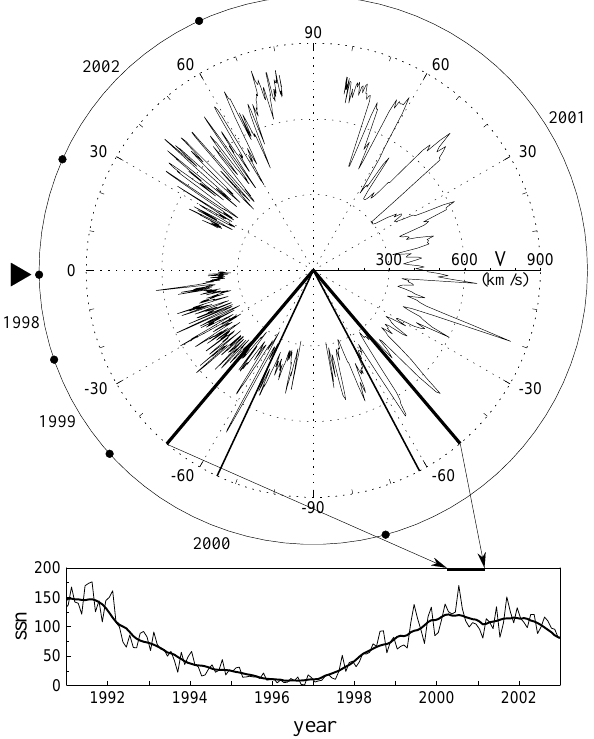
Fig. 1. A polar plot of the solar wind velocity ˇ vs. heliographic latitude is shown at the top for years 1998 to 2002. Dots along the outermost circle mark the beginning of each year, with time in- creasing anticlockwise from the leftmost dot (see arrowhead). The bottom panel gives solar sunspot numbers (ssn) in terms of monthly and smoothed values (thin and thick line, respectively) for a 12-year interval starting in 1991. The angular sector indicated by thick lines in the top plot and the thick segment in the bottom plot identify the analysed interval. A narrower sector delimited by lighter lines identifies a very-high-latitude subinterval, see text.